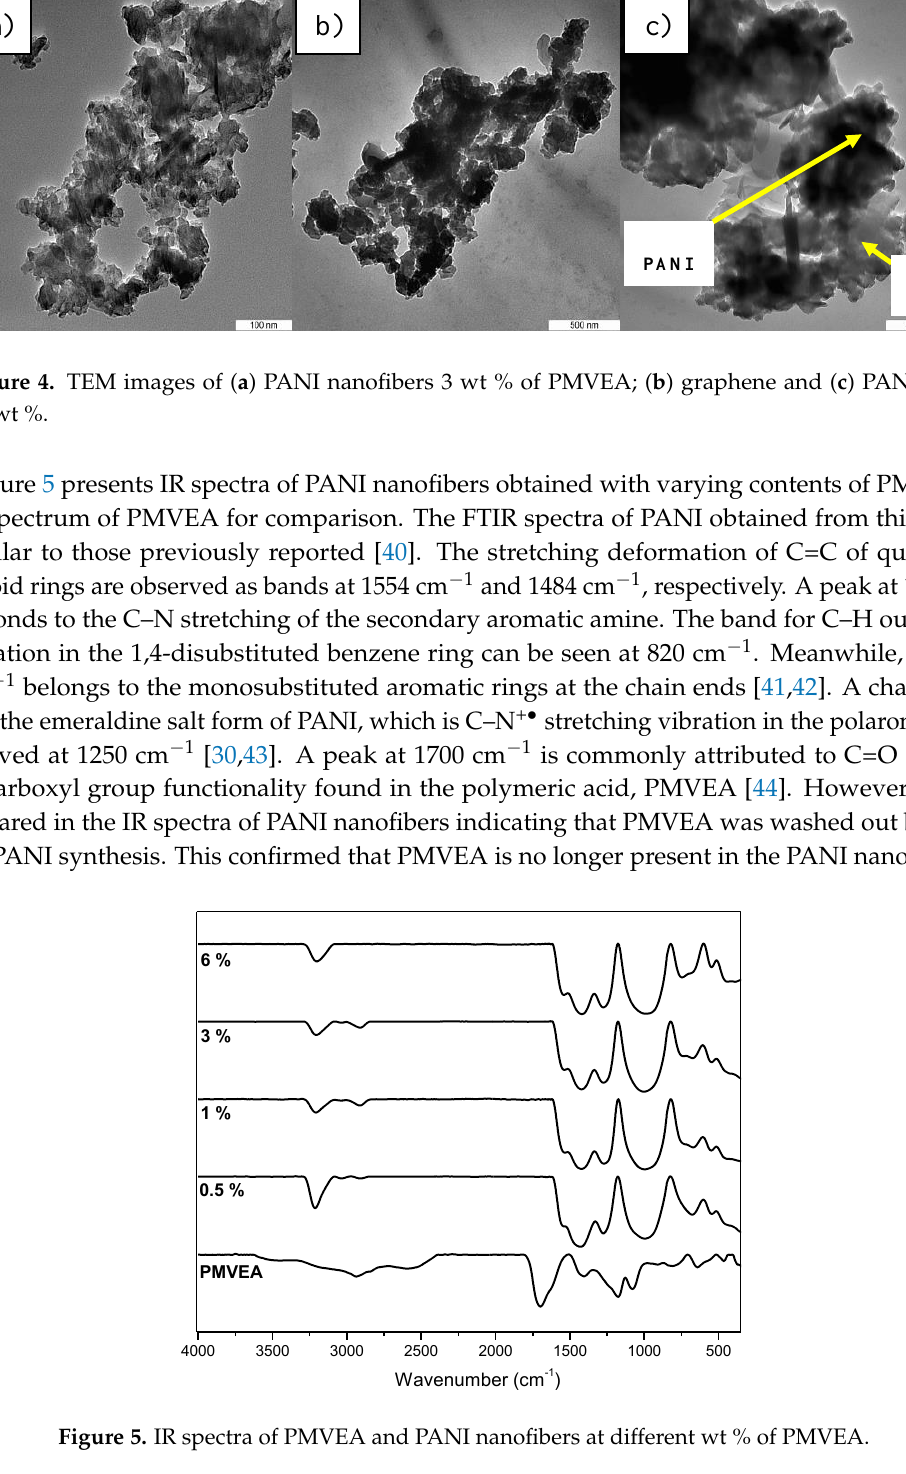
%; ( c ) 25 wt %; ( d ) 50 wt % and ( e ) graphene.